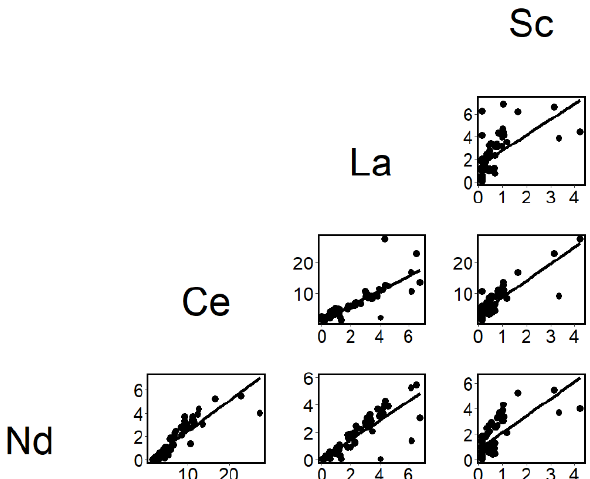
Figure 2. The associations between the concentrations of the rare earth elements Sc, La, Ce and Nd in rotated component 1 (ng/m 3 ).